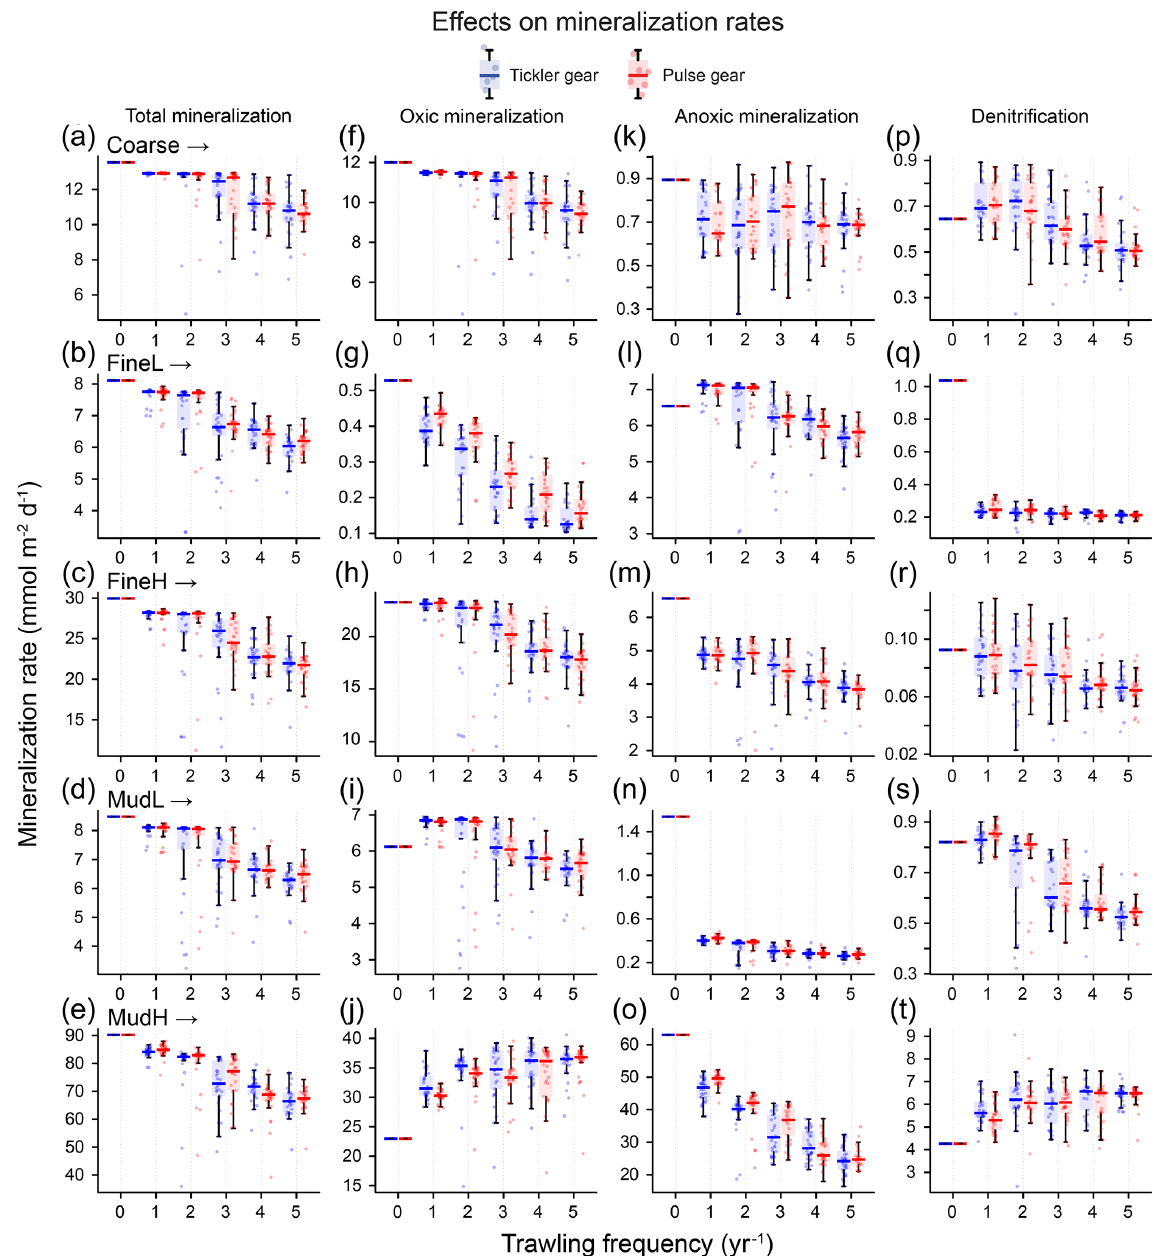
Figure 6. Rates of total mineralization (a–e) , and the three main mineralization processes ( f–j : oxic; k–o : anoxic; p–t : denitrification) ( y axis, mmolm − 2 d − 1 ) for each gear type (blue boxes: tickler gear; red boxes: pulse gear) and for increasing trawling frequency ( x axis, yr − 1